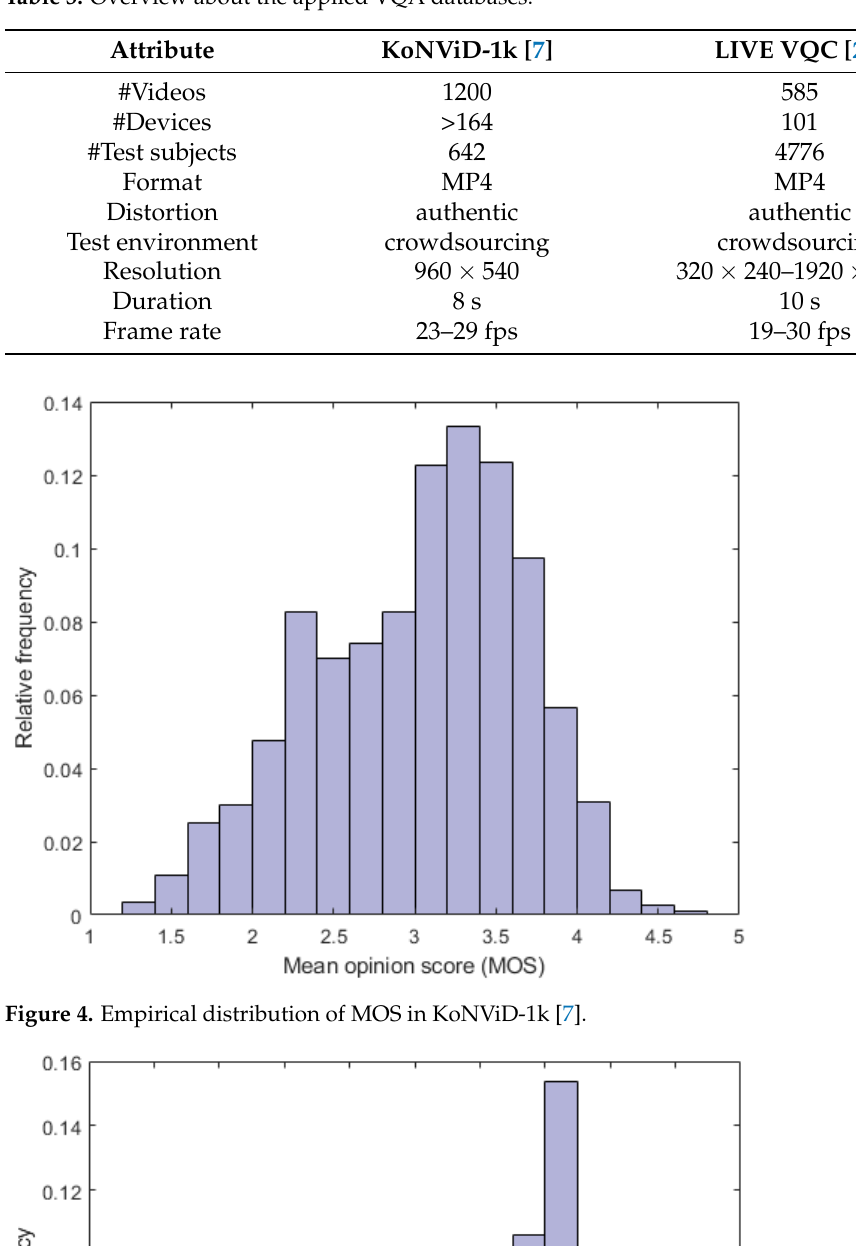
Table 3. Overview about the applied VQA databases.